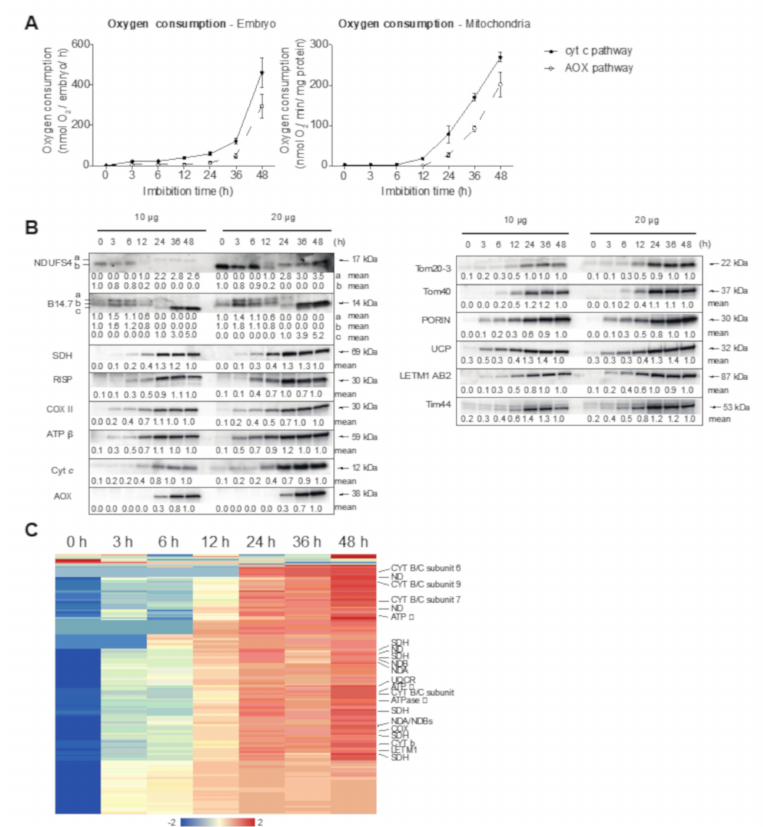
Figure 8. Mitochondrial dynamics during barley grain germination. ( A ) Oxygen consumption in whole embryos and isolated mitochondria. Oxygen consumption was examined in whole barley embryos and isolated mitochondria using a Clark-type oxygen electrode. Each data point represents an average of three to four independent measurements. ( B ) Changes in abundance of mitochondrial proteins. A representative image is shown from probing three independent isolated mitochondrial proteins using both 10 and 20 µ g of isolated protein. The abundance of the protein is normalized to a value of 1 at 48 h and all other values are expressed in a relative manner. For NDUFS4 “a” and “b”, all values are relative to 12 h and 0 h, respectively. For B14.7 “a”, “b”, and “c”, all values are relative to 0 h, 0 h, and 24 h, respectively. The apparent molecular mass is indicated in kDa. NDUFS4 = 17 kDa subunit complex I, B14.7 = complex I subunit, SDH = subunit I of succinate dehydrogenase / complex II, RISP = Rieske FeS protein of complex III, COXII = cytochrome oxidase II of complex IV, ATP β = β subunit of ATP synthase, Cyt c = cytochrome c, AOX = alternative oxidase, Tom20-3 = translocase of the outer membrane 20-3, Tom40 = translocase of the outer membrane 40, Porin = voltage-dependent anion channel, UCP = uncoupling protein, LETM1 = leucine zipper-EF-hand-containing transmembrane protein 1, Tim44 = translocase of the outer membrane 44. ( C ) The heatmap represents the abundance of 173 mitochondrial proteins at the indicated time points after seed inhibition. Quantification was performed by proteomic analysis (label-free quantification) of purified mitochondrial proteins, and abundances are represented by z-scored intensity-based absolute quantification (iBAQ) values. The position of several protein isoforms is indicated in the heatmap (see Table S10 for details): CYC B / C, CYTOCHROM b / c subunit; ND, NADH DEHYDROGENASE; SDH, SUCCINATE DEHYDROGENASE; NDA / NDB, ALTERNATIVE NAD(P)H DEHYDROGENASE; COX, CYTOCHROME OXIDASE; LETM1, LEUCINE ZIPPER-EF-HAND-CONTAINING TRANSMEMBRANE PROTEIN